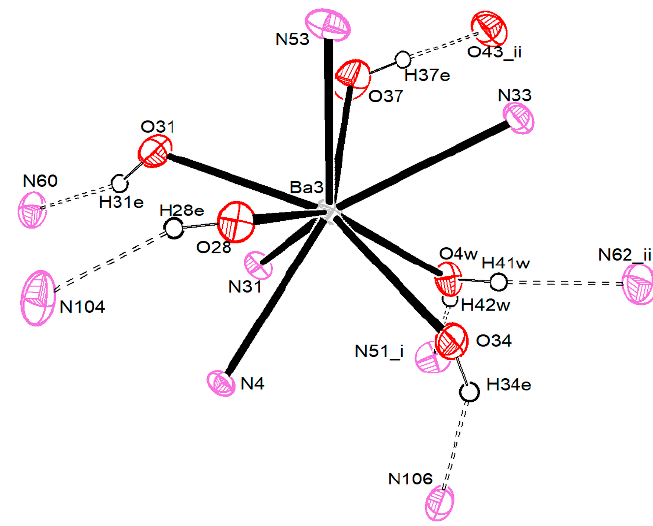
Figure 22 . The first and second coordination spheres of Ba3. Figure 22. The first and second coordination spheres of Ba3.